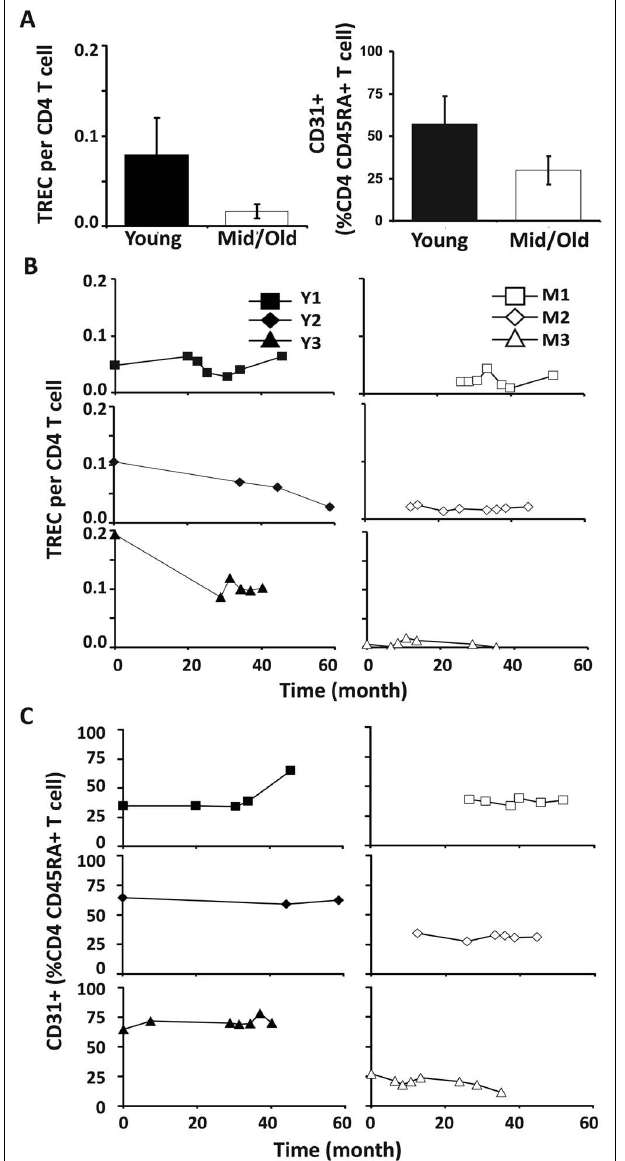
FIGURE 3 | Decreased thymic CD4 output was observed in young but not middle-aged donors. (A) TREC counts (left) and CD31 + percentages in naïve CD4T cells (right) of young and middle-aged donors. PBMC were isolated from leukapheresis blood and CD4T cells were further isolated via positive selection.TREC content was examined longitudinally byTaqman Real time PCR. CD31 expression was determined by flow cytometry analysis.The average of all time points were presented with the SD ( P ≤ 0.05). (B) TREC frequencies in CD4T cells isolated from young (left panels) and middle-aged (right panels) donors are shown. (C) CD31 + CD45RA + CD4T